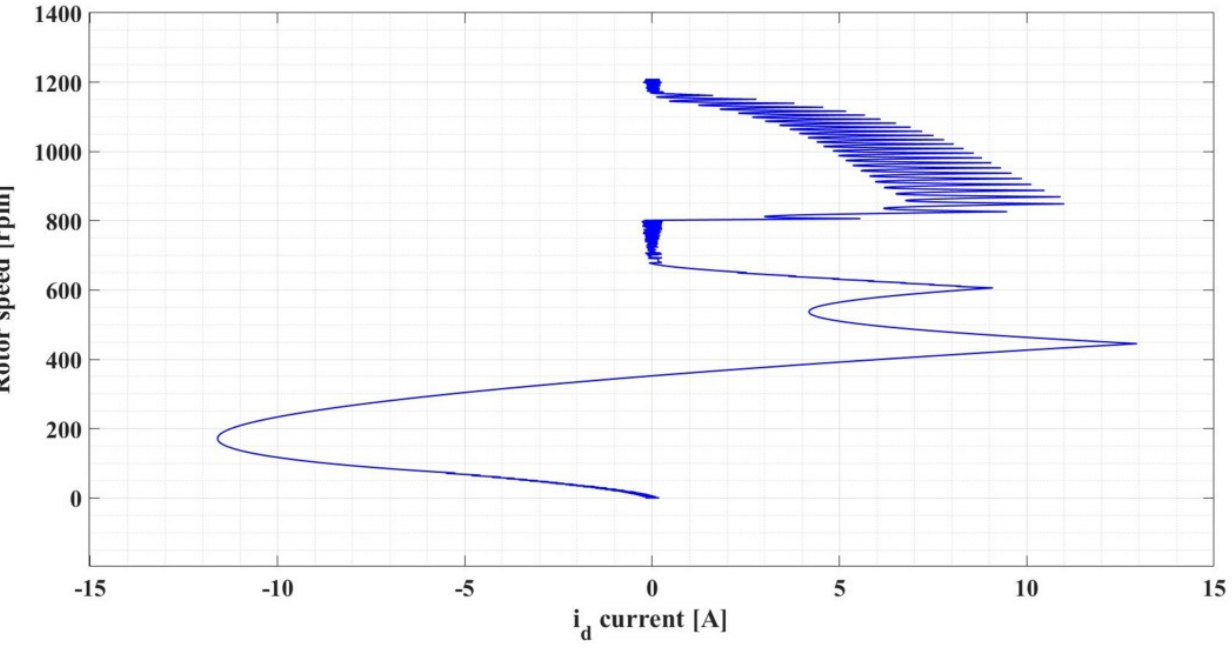
Figure 28. Image of the phase plan for PMSM variable structure with switching signal type 2: rotor speed versus i d current ( ω ref = 800 rpm).